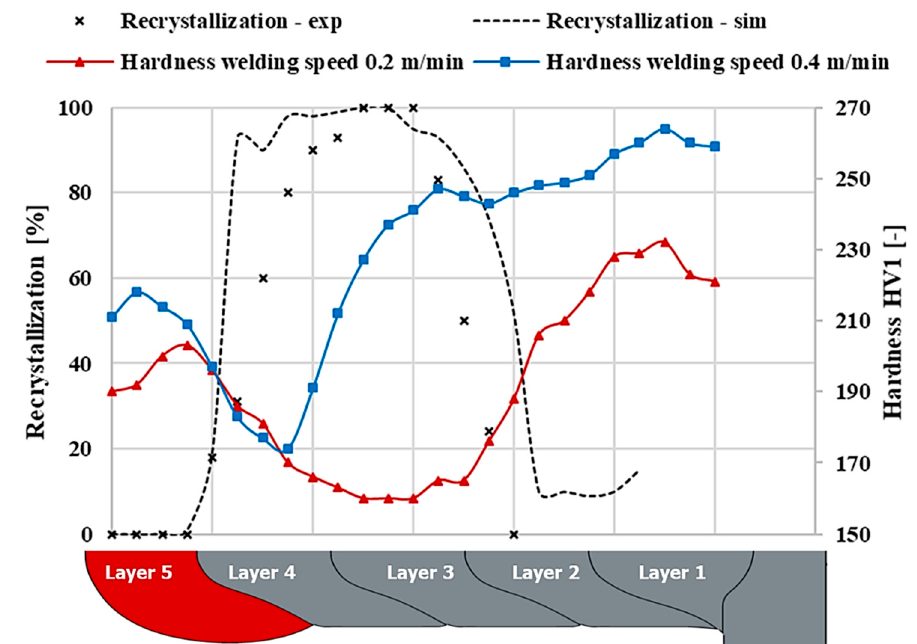
Figure 6. Simulated and experimental fraction of recrystallization and measured hardness distribution in each layer for strategy 2.